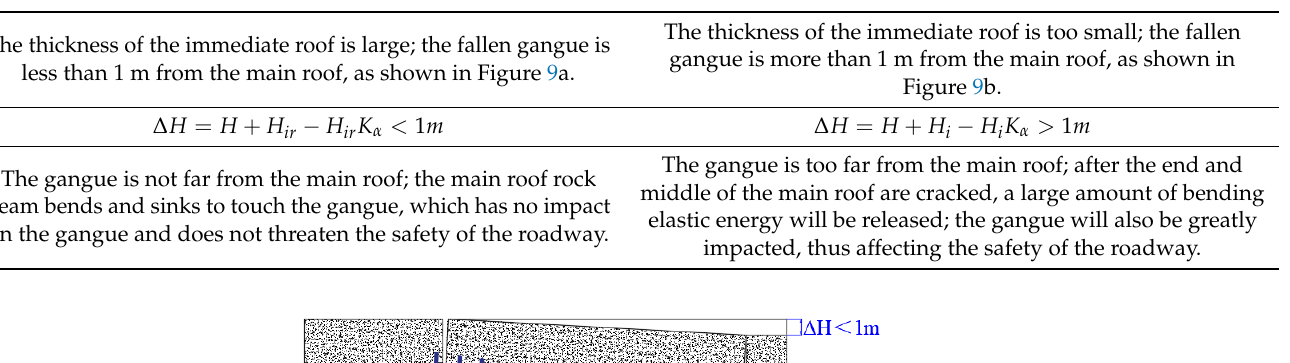
Table 3. Determination of gangue impact [40].